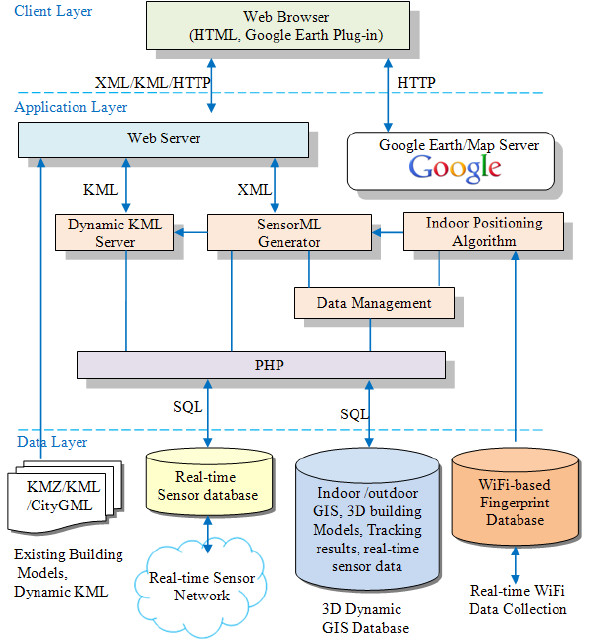
Figure 1. General system architecture for implementing dynamic 3D virtual